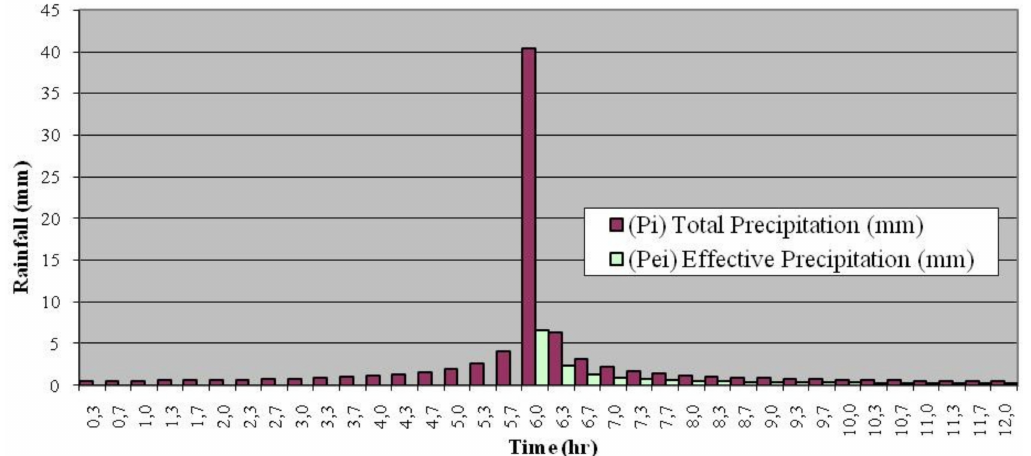
Figure 6. The effective precipitation hyetograph for a 140-year, 12-h duration storm event for the year